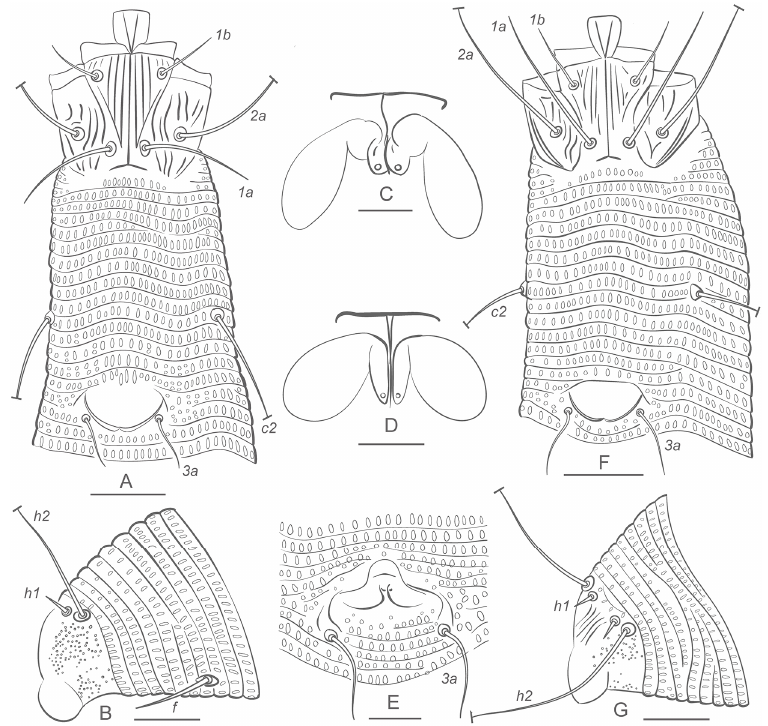
Figure 7. Drawings of coxigenital area ( A , F ), telosome ( B , G ), female internal genitalia ( C , D ), and male genital area ( E ) of Novophytoptus zuluensis n. sp. ( A – C ) and N. limpopoensis n. sp. ( D – G ). Scale bar: ( A , B , F , G ) = 10 µ m; ( C – E ) = 5 µ